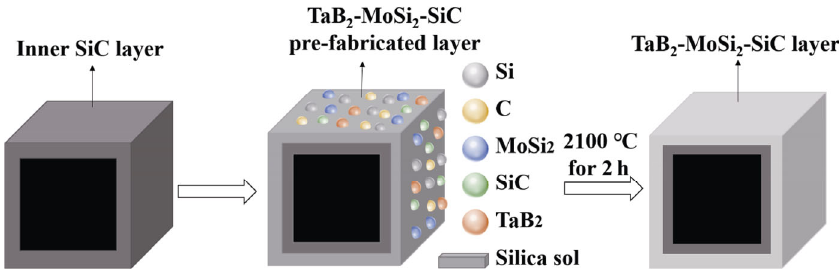
Fig. 1 Fabricating process of the TaB 2 –SiC–MoSi 2